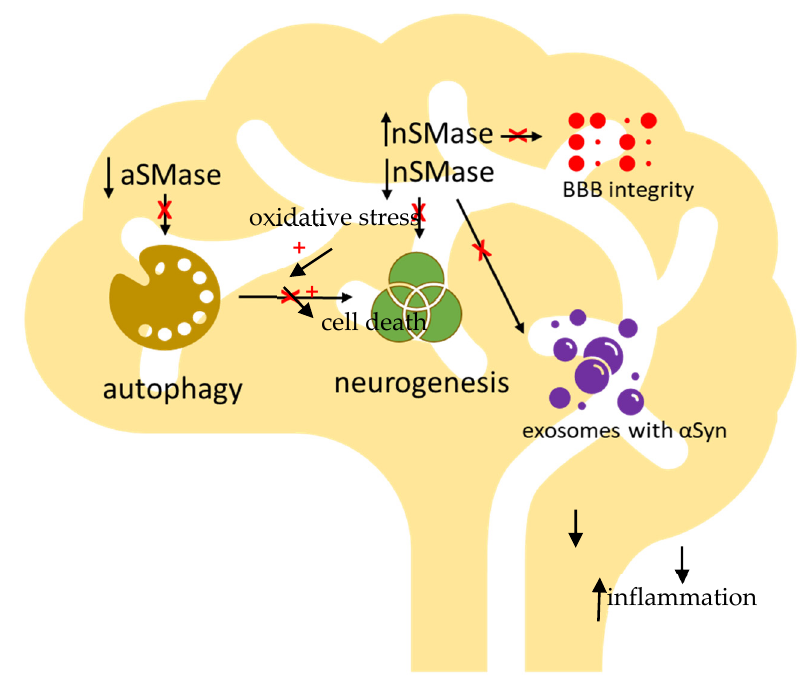
Figure 3. Schematic representation of main alterations induced by the SM metabolism disorder in PD. Reduction of acid sphingomyelinase (aSMase) impairs autophagy, which is a process necessary to allow neurogenesis to occur. Activation of aSMase by free radicals is responsible for cell death. Reduction of neutral sphingomyelinase (nSMase) is responsible for the inhibition of stem cell dif- ferentiation, hindering the neurogenesis, and for the slowed release of exosomes containing α Syn, limiting its degradation by extracellular enzymes and stimulating inflammation.